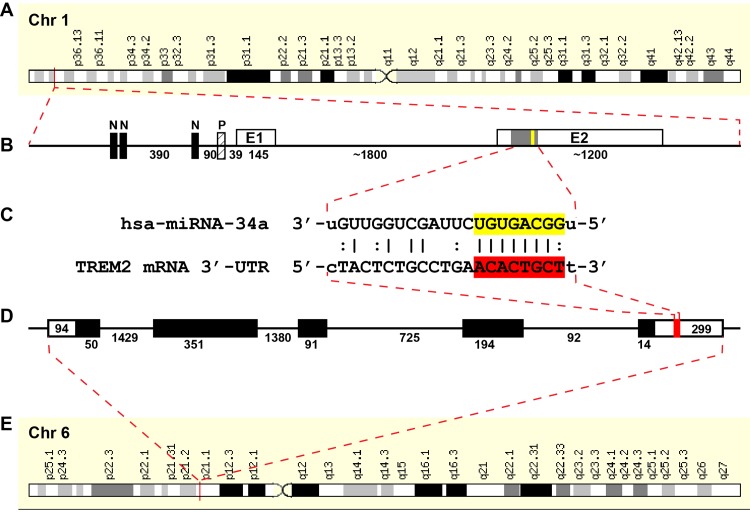
(A) Schematic complementarity map for a micro RNA-34a-TREM2 mRNA-3’-untranslated region (hsa-miRNA-34a-TREM2-mRNA-3’UTR) interaction between primary gene products on chromosome 1 and 6 [12]; human sequences shown; not drawn to scale; (B) hsa-miRNA-34a, encoded chr1p36.15 contains 3 canonical NF-kB sites (N) in the upstream promoter (http://www.genecards.org/cgi-bin/carddisp.pl?gene=MIR34A) [8,12,56];; E1 = exon 1; E2 = exon 2 of the miRNA-34a gene; miRNA-34a expression is known to be NF-kB-sensitive in human brain cells [12,58]; (C) miRNA-34a precursor is processed into a mature 22 nucleotide hsa-miRNA-34a sequence; the free energy of association (EA) between hsa-miRNA-34a and the TREM2 mRNA-3’UTR sequence is ~16.2 kcal/mol; the miRNA-34a seed sequence 3’-UGUGACGG-5’ is overlaid in yellow; the complementary TREM2-3’-UTR recognition (DNA) sequence 5’-ACACTGCT-3’ is overlaid in red; an ‘|’ indicates a full hydrogen bond between miRNA-34a and the TREM2-mRNA-3’UTR and a ‘:’ indicates a partial hydrogen bond; (D) the hsa-miRNA-34a recognition feature within the TREM2-3’UTR is located about midway in the 299 nucleotide (nt) TREM2-3’UTR; several other brain-enriched miRNAs located within the TREM2-3’UTR and may also affect TREM2 mRNA stability and regulate its expression; sequence structures in (B) and (D) are not drawn to scale; (E) TREM2 is encoded as a single copy gene at human chr6p21.1; the primary transcript is a 2.7k nt TREM2 mRNA (http://www.genecards.org/cgi-bin/carddisp.pl?gene=TREM2) with a half-life of about 20 hr [60]; it is noteworthy that the TREM2 gene has no strong NF-kB binding site within at least 11 kb of its transcription start site and NF-kB activation has no strong effects on TREM2 transcription (unpublished); single stranded ribonucleotide sequences and alignment derived using miRBASE algorithms (European Bioinformatics Institute, Wellcome Trust Genome Campus, Hinxton UK; srv/microcosm/cgi-bin/targets/v5/ detail_view.pl? transcript_id = ENST00000 373113) [3–6,8,12,20,56,58].